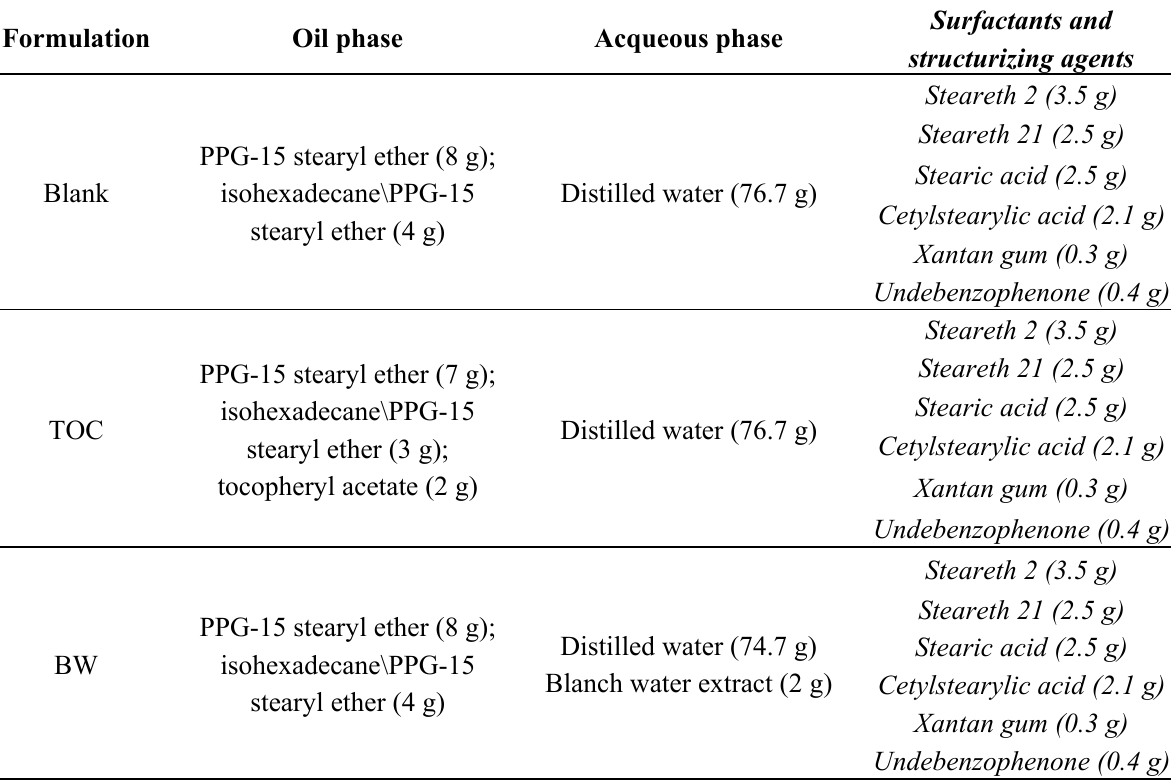
Table 5. Composition of the topical formulations containing the Blanch Water (BW) extract or tocopheryl acetate as reference substance (TOC), or without active ingredients